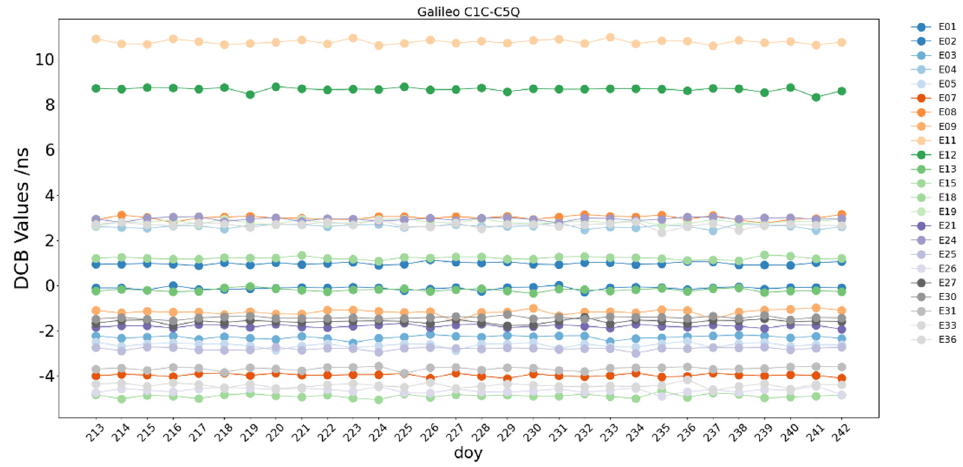
Figure 23. C1C–C5Q DCB time series of Galileo satellites.